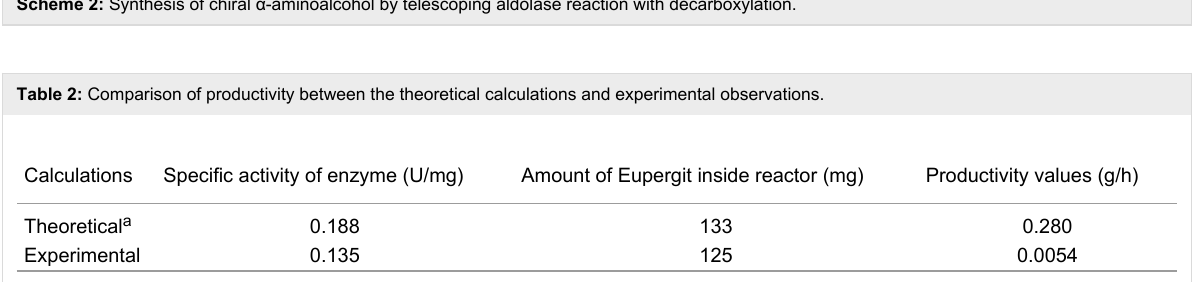
Calculations Specific activity of enzyme (U/mg) Amount of Eupergit inside reactor (mg) Productivity values (g/h) Theoretical a 0.188 0.280 Experimental 0.135 0.0054